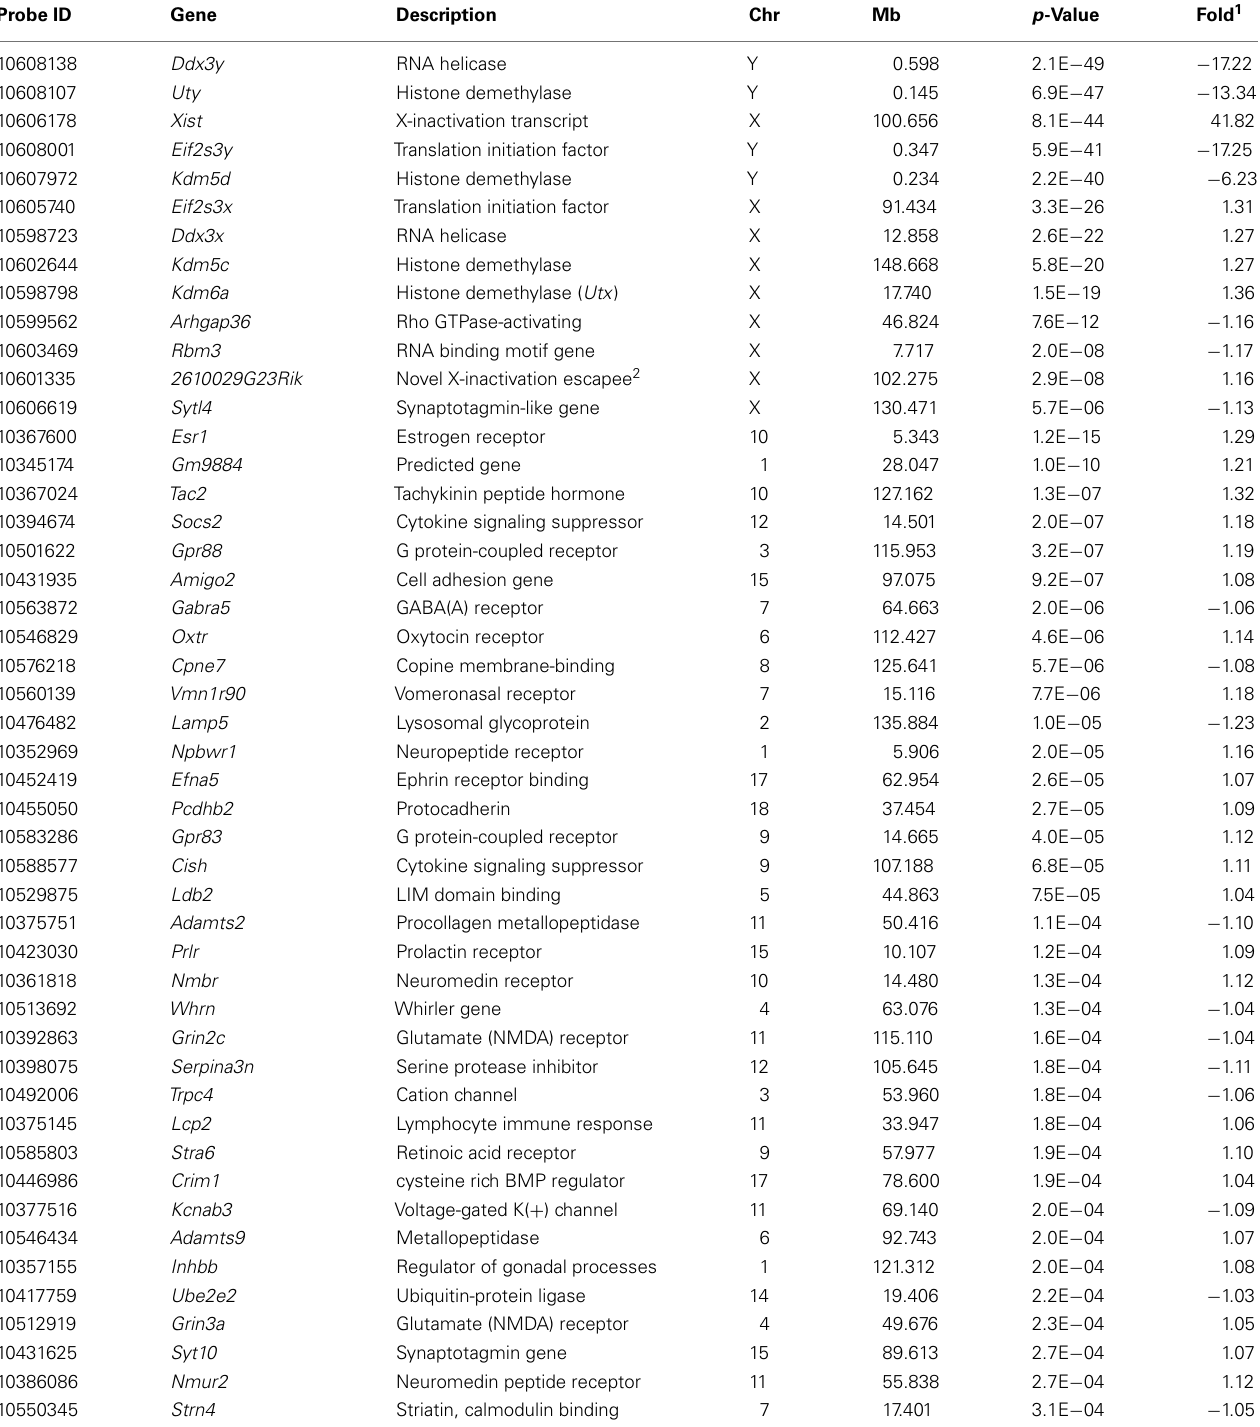
Table 1 |Transcripts with differential expression (FDR of 0.10) between males and females in the hypothalamus. Probe